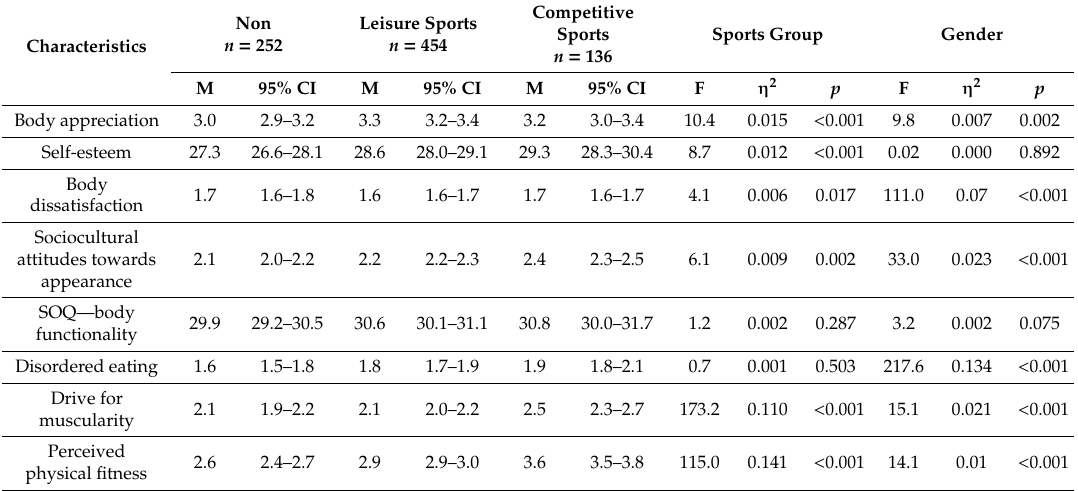
Table 3. The comparison of body image, disordered eating behaviours and lifestyle-related factors in sports groups in a sample of girls ( n =